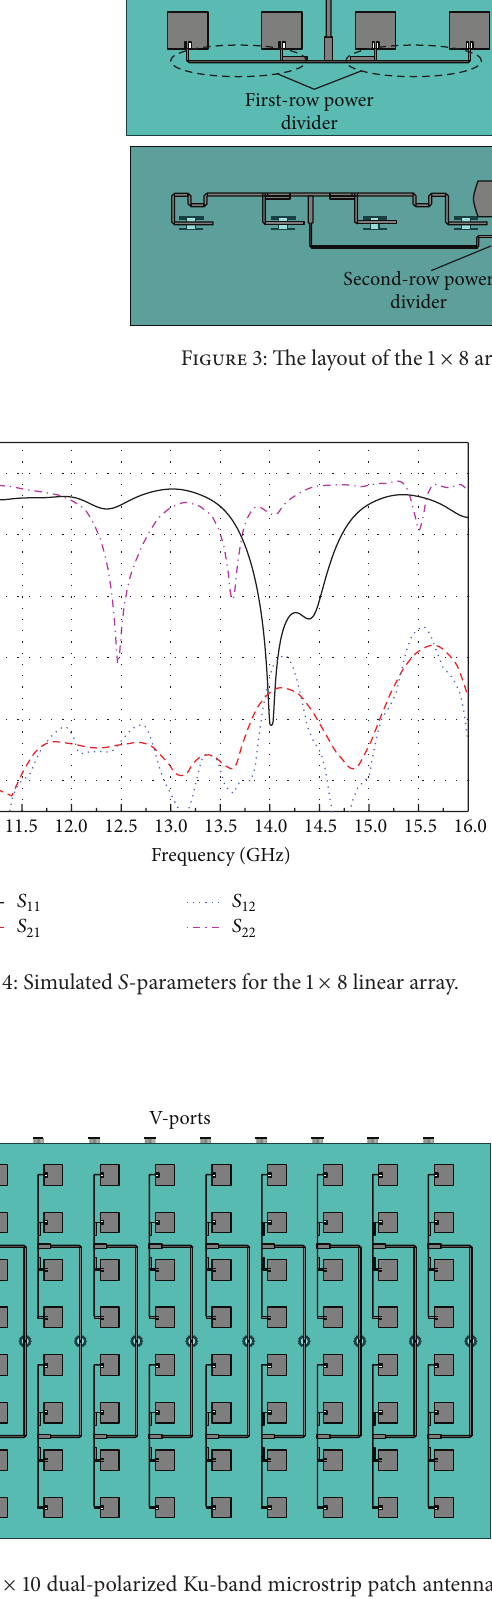
Figure 5: 8 × 10 dual-polarized Ku-band microstrip patch antenna array simulation model.